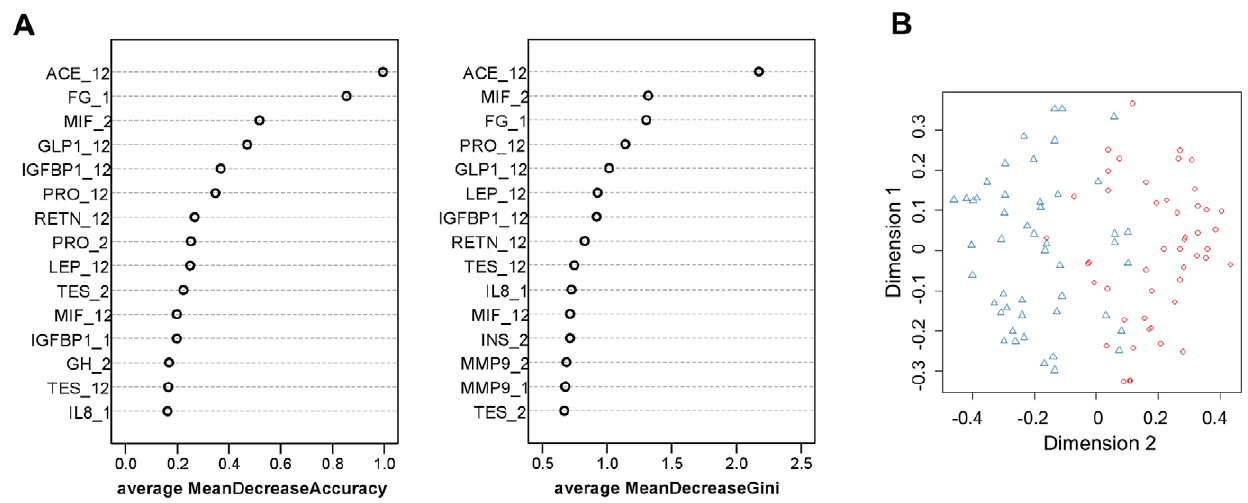
Figure 2. Top 15 important predictors for weight loss maintenance identified by Random Forest. A . The variables are ranked by the average of 10 runs on the mean decrease in classification accuracy (MDA) or by the mean decrease in classification Gini impurity (MDG). Suffix ‘‘_1’’: concentration at CID1, ‘‘_2’’: concentration at CID2, ‘‘_12’’: fold change of the concentration (CID2/CID1). The symbol of blood analytes are listed in Table 1. B . Classification plot of continued weight-losers (red dots) and weight-regainers (blue triangles) during weight maintenance in pooled subjects (n=96) by the top15 important variables. doi:10.1371/journal.pone.0016773.g002 (r = 0.611, p , 0.001 in Pearson correlation on Ln-transformed values). Nine of the top 15 most important variables from RF overlapped with significant or tending to be significant variables from logistic regression. The fold change of ACE was identified as the most important variable by both methods. For the top 5, only baseline FG is different from the logistic regression outcome. Its importance is even clearer when MDA is used for ranking.